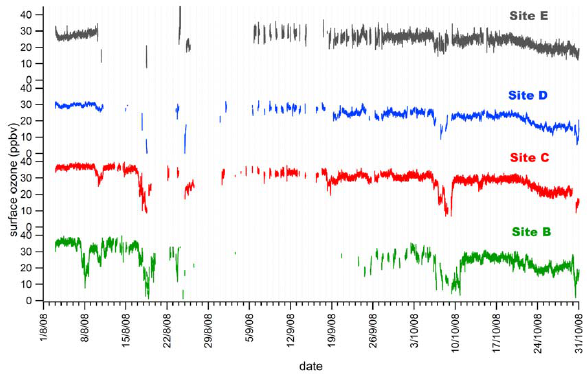
Fig. 9. Surface ozone (10-min averages) from 1 August 2008 to 31 Figure 9. Surface ozone (10 ‐ minute averages) from 1 st August 2008 to 31 st October 2008 at 4 sites 619 October 2008 at 4 sites from a transect on the slope of the Antarctic from a transect on the slope of the Antarctic plateau. Site E at 2000 m asl, Site D at 1030 m asl, Site C 620 plateau. Site E at 2000 ma.s.l., Site D at 1030 ma.s.l., Site C at 500 at 500 m asl, Site B at the coast (30 m asl). 621 ma.s.l., Site B at the coast (30